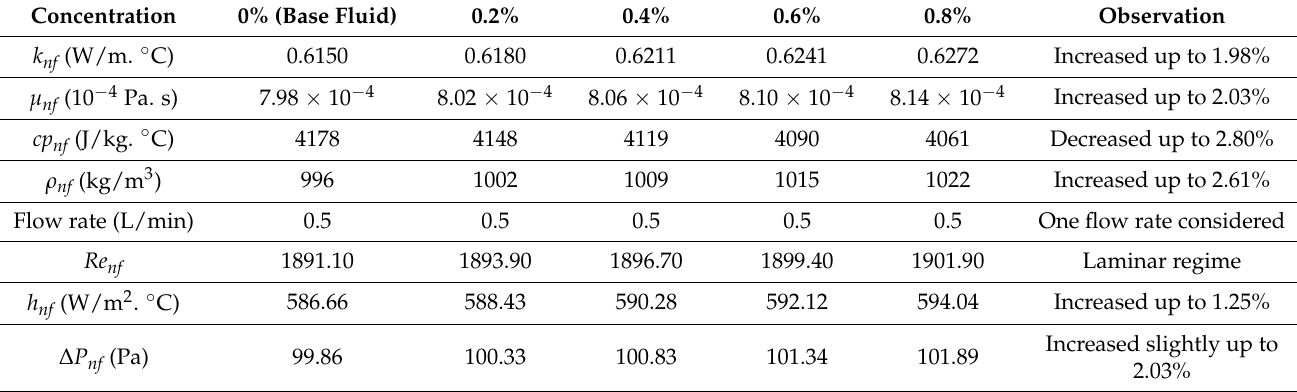
Table 6. Summary of nanoparticle volume concentration variation effects on nanofluid thermophysi- cal properties, heat transfer, and pressure drop of heat